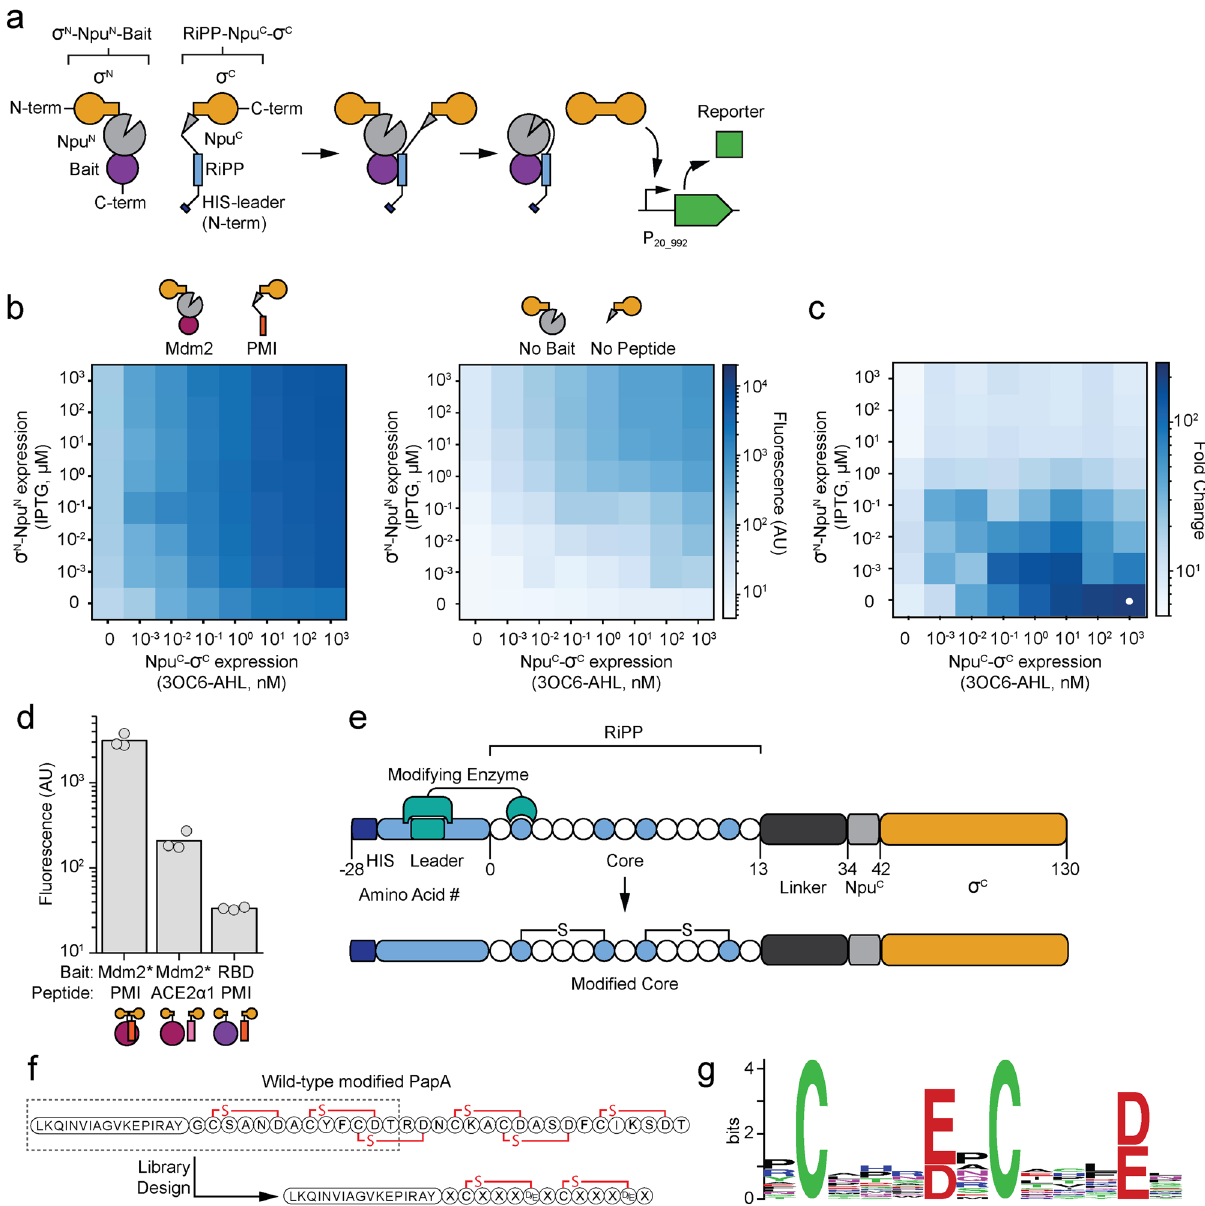
Fig. 1 Split intein system for in vivo detection of protein – protein interactions. a A schematic is shown for the detection of a binding event between a RiPP and target. A split intein from Nostoc punctiforme PCC73102 (Npu), is used to splice together a σ factor for downstream transcription. b Inducible interaction-mediated splicing. The median fl uorescence is shown as a function of the expression of the two halves of the sensor proteins. The induction of PMI- and Mdm2*-driven association (left) or split intein alone (right) are shown. The plots are a representative replicate selected from three performed on different days. c The speci fi city is calculated using the data in part b: (Fluorescence Mdm2* + PMI /Fluorescence no bait + no peptide ). The white dot marks the highest fold-change in expression. d The fl uorescence measured from the circuit containing a binding pair (Mdm2*:PMI) and non-binding pairs are compared. The 3OC6-AHL concentration for all inductions was 1 µ M. Three replicates performed on different days are shown. e A schematic of the RiPP- containing half of the split intein system is shown, with the modi fi ed core residues in blue. f The structure of the wild-type PapA modi fi ed peptide 56 is shown with a box around the region used to design the peptide library and the resulting scaffold sequence. g Library sequence weblogo for the 14 modi fi ed library variants observed